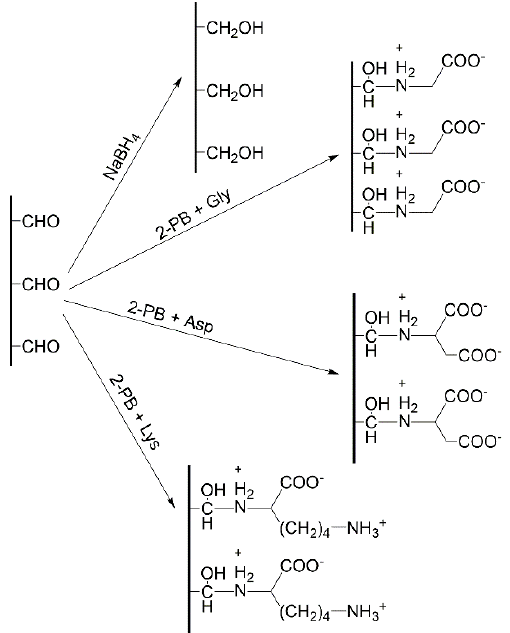
Figure 2. The schematic representation of the different microenvironments generated on the support surfaces.